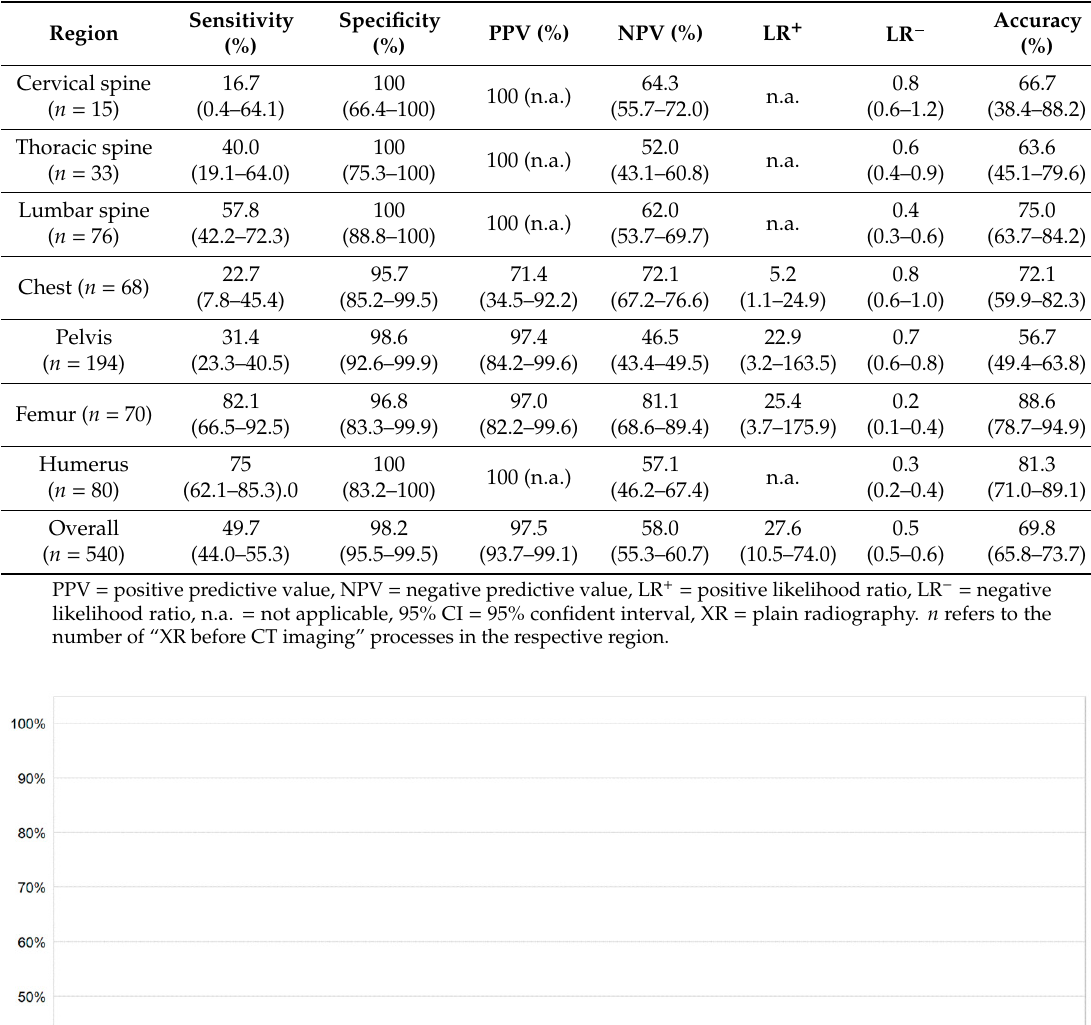
Table 3. Summary of measurements of diagnostic accuracy (95% CI) of XR for fracture detection according to computed tomography as reference standard.